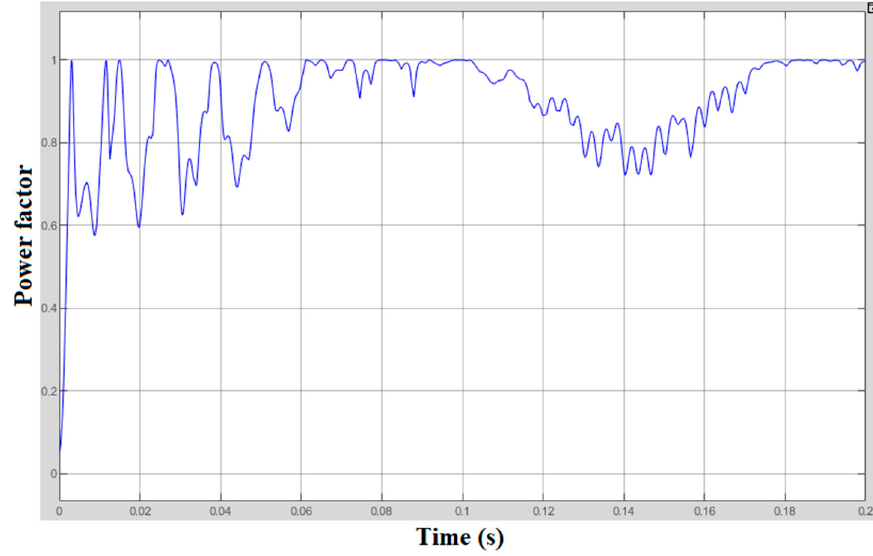
Figure 13. Power factor.